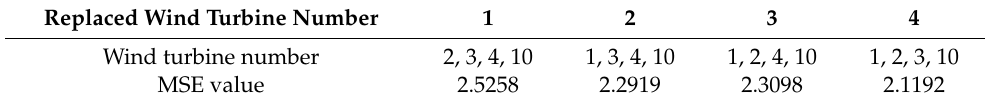
Table 2. MSE values of wind turbine NO. 10 instead of wind turbine Nos. 1–4. Replaced Wind Turbine